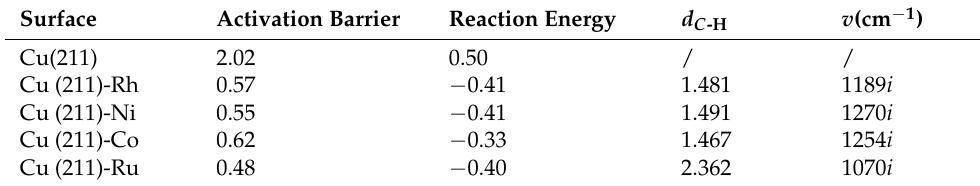
Table 4. The activation barrier (eV) and reaction energy (eV) of carbon dioxide hydrogenation via COOH intermediate on the pure and transition-metal-doped Cu(211)-M (M = Rh, Ni, Co, and Ru) surfaces together with the C–H bond length ( d C-H /Å) in the transition state and the corresponding imaginary frequency of the transition state v (cm − 1 ).